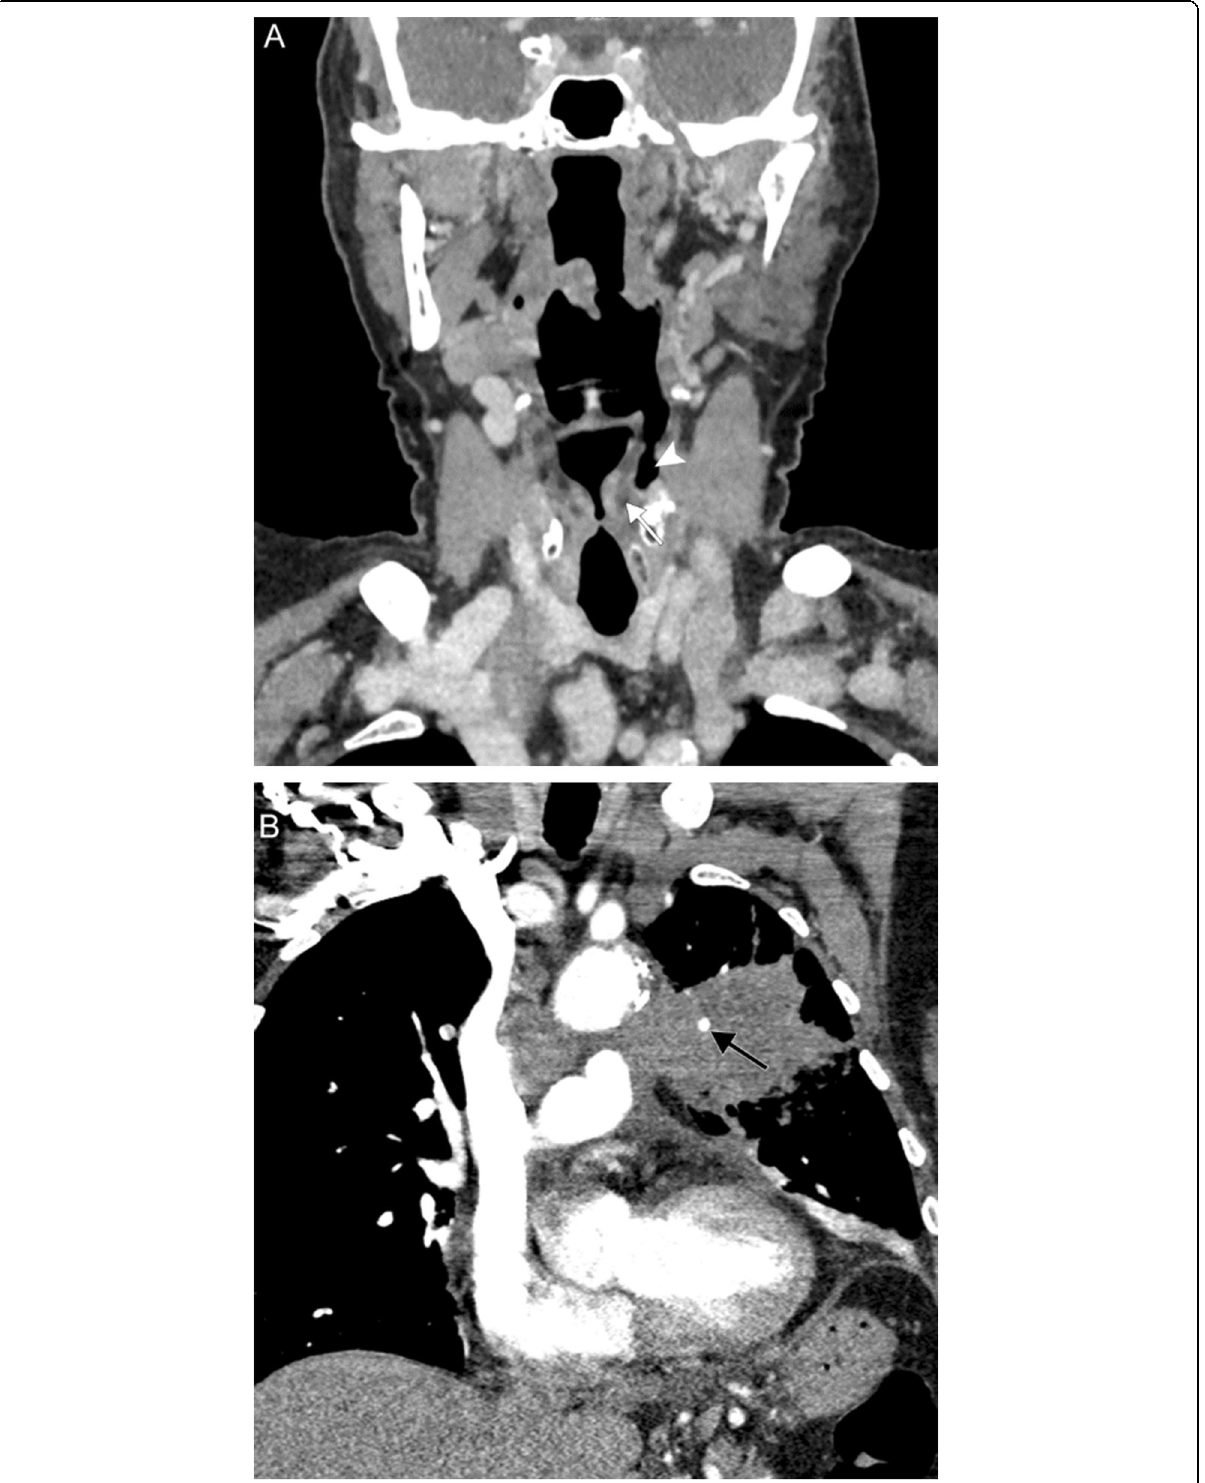
Fig. 19 Lung cancer. A 79-year-old woman with 55-pack-year smoking history presenting with hoarse voice and chronic vomiting. Coronal contrast- enhanced images of the larynx ( a ) and lungs/mediastinum ( b ) reveal medialization of the left vocal fold (white arrow) with dilation of the ipsilateral piriform sinus (white arrowhead). A large mass centered in the left upper lobe extends into the aortopulmonary window and also encases a vessel (black arrow). These findings are consistent with left vocal cord paralysis due to compression of the left recurrent laryngeal nerve in the setting of stage IV lung